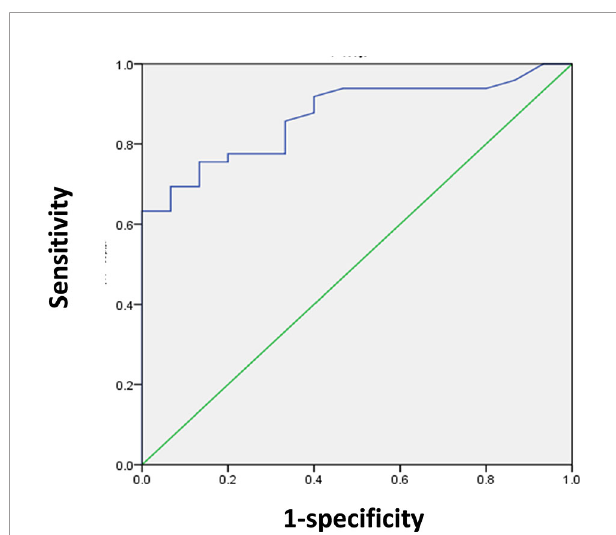
FIGURE 2 | ROC analysis for the differentiation of malignant from benign upper urinary tract occupying in 64 patients. The area under curve was 0.870 (95%CI 0.783 – 0.957, P < 0.001), and 6.75 was the optimal SUVmax for predicting malignant lesions. When SUVmax of lesion was 6.75, sensitivity and speci fi city for the prediction of malignant lesions were 75.5% and 86.7%,